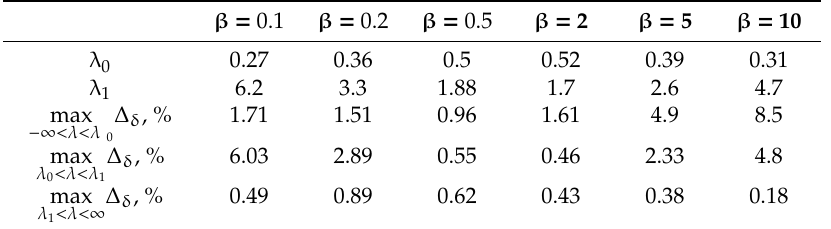
Table 3. Maximum relative error ∆ δ of the simplified expression δ P in di ff erent ranges of λ . β = 0.1 β = 0.2 β = 0.5 β = 2 β =